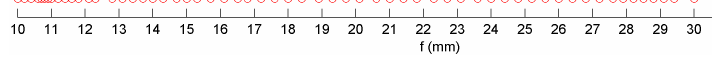
Table 4. Multi-focal triangulation accuracy evaluation. Table 4 . Multi-focal triangulation accuracy evaluation.